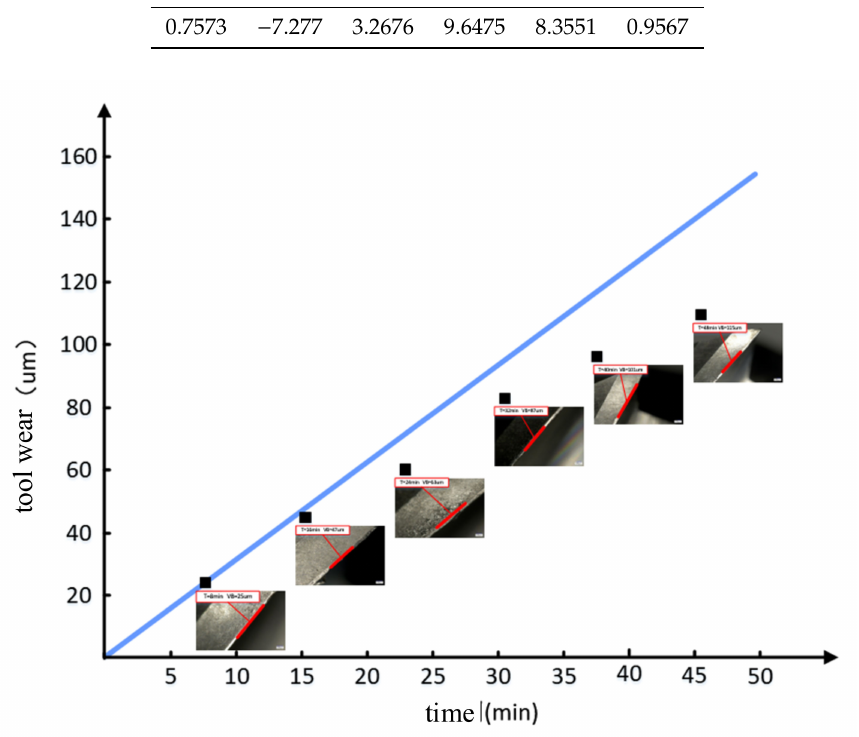
Figure 14. Comparison of abrasion VB between simulation and experiment for milling cutter flank